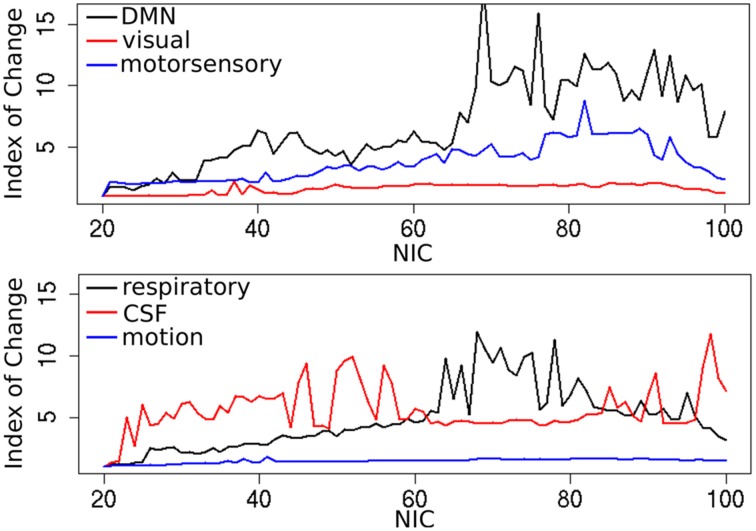
Change index of spatial overlap and temporal association (CISOTA) as function of NIC for three typical RFNs (top) and artifact (bottom) components.